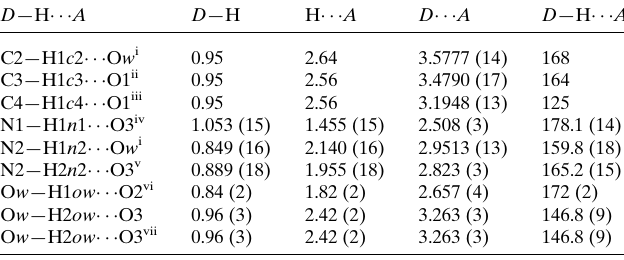
Figure 1 The title molecule, with anisotropic atomic displacement ellipsoids shown at the 50% probability level ( PLATON ; Spek, 2009).